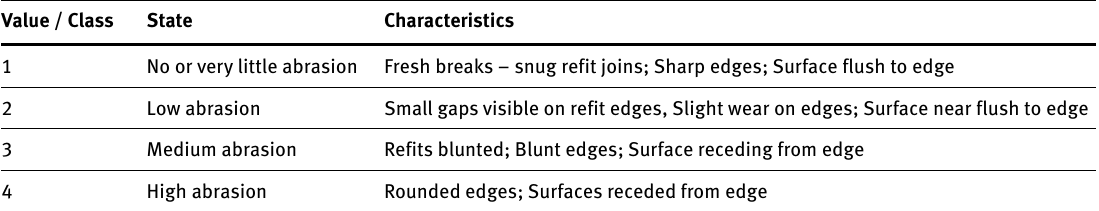
Table 1. Recording system employed to categorise states of erosion of sherds ( cf. Edwards 2009). Value / Class State